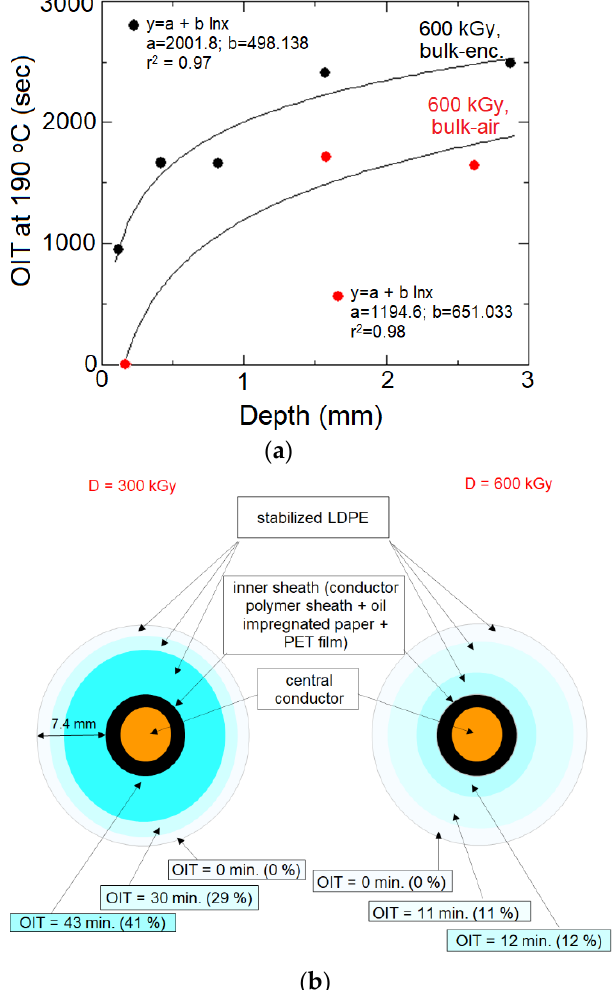
Figure 11. ( a ) Longitudinal oxidation profiles from OIT measurements in PE insulator of C3 cable